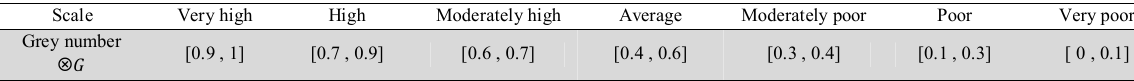
Scale for SERVQUAL linguistic variables section